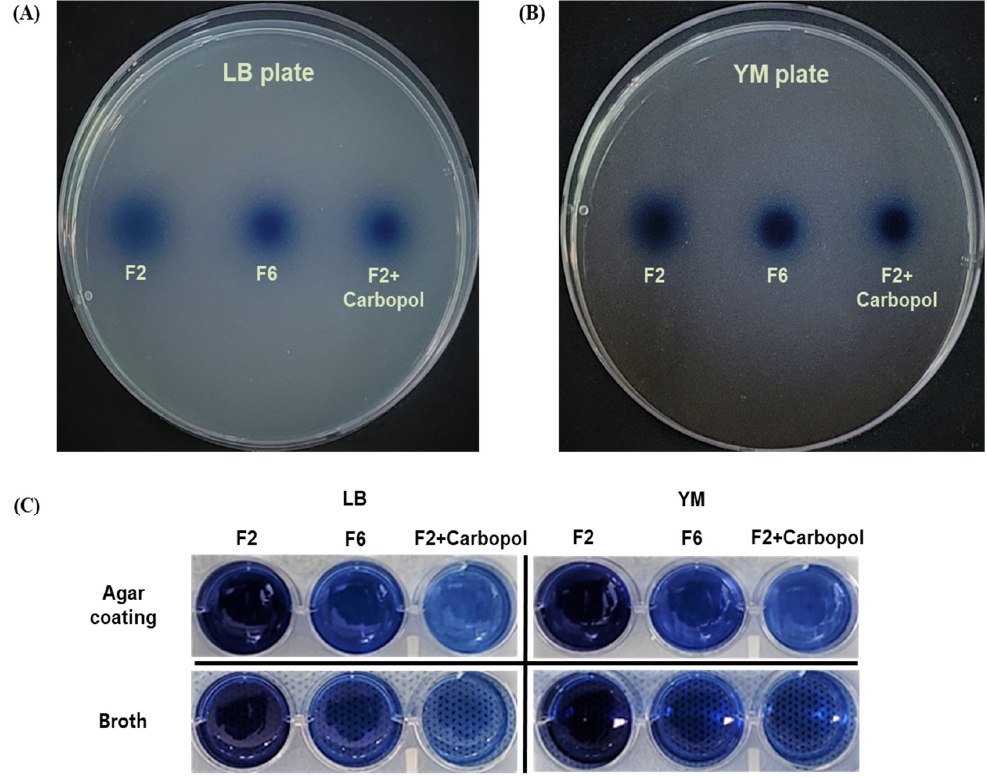
Figure 4. Diffusion patterns of trypan blue in P188, P407, and Carbopol added P188 formulations. ( A ) diffusion in Luria-Bertani (LB) agar plates after standing at 37 °C, ( B ) diffusion in yeast malt (YM) agar plates after standing at 30 °C, ( C ) Diffusion across Transwell inserts with and without agar coating.